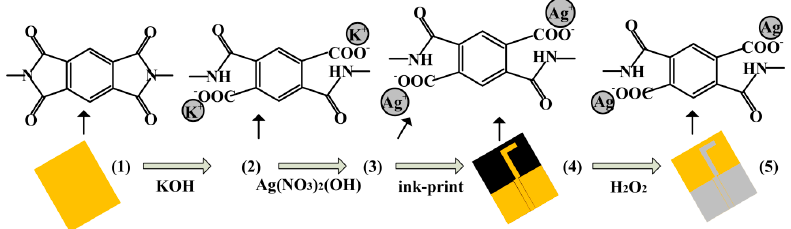
Figure 3. The manufacture process of the antenna.